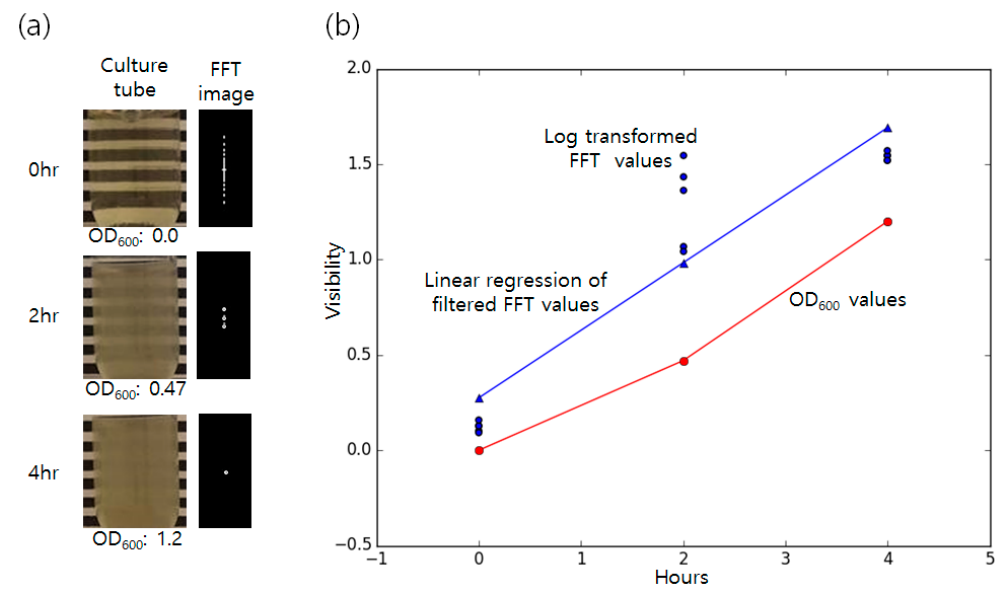
Figure 4. Visibility of the bacteria at different time points. ( a ) Visibility of the culture bottle (left) and fast Fourier transform (FFT) pattern (right) changes as time passes (0, 2, 4 h). The corresponding conventional OD 600 values are shown for each time point; ( b ) The plot shows the change of the measured visibility as time passes. The red line indicates the OD 600 value of the sample at a given time. Blue dots are log transformed visibility obtained by the FFT measurement (ratio of the blurred region count and blank region count). Count means the size of the white region of the FFT images. The blue triangles and line show linear regression result of the FFT measured values. The OD 600 and the FFT result showed a correlation coefficient of 0.992.